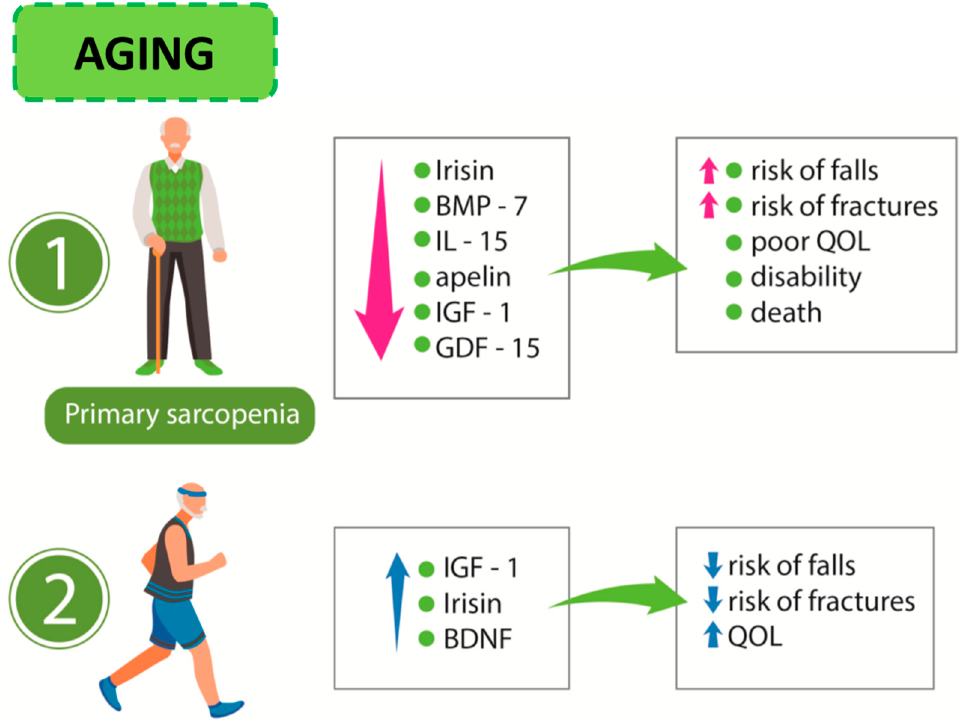
Figure 2. Aging process: (1) sarcopenia and its consequences and (2) influence of exercise on the release of myokines. BMP-7: bone morphogenetic factor-7; IL-15: interleukin-15; IGF-1: insulin-like growth factor-1; GDF-15: growth / di ff erentiation factor-15 BDNF: brain-derived neurotrophic factor; QoL: quality of life.